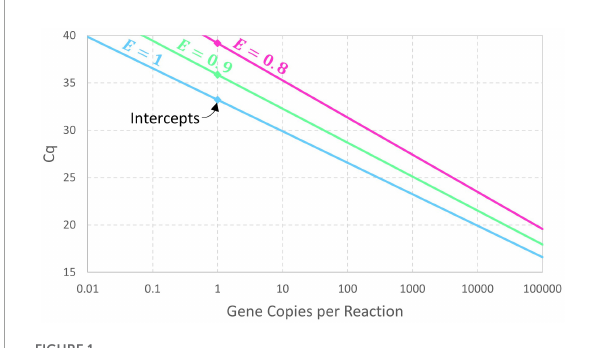
FIGURE1 Deterministic log-linear standard curve model with amplicon detection threshold N q = 10 10 and amplification efficiency E having values of 1, 0.9, and 0.8. The corresponding intercept values are 33.22, 35.87, and 39.17,